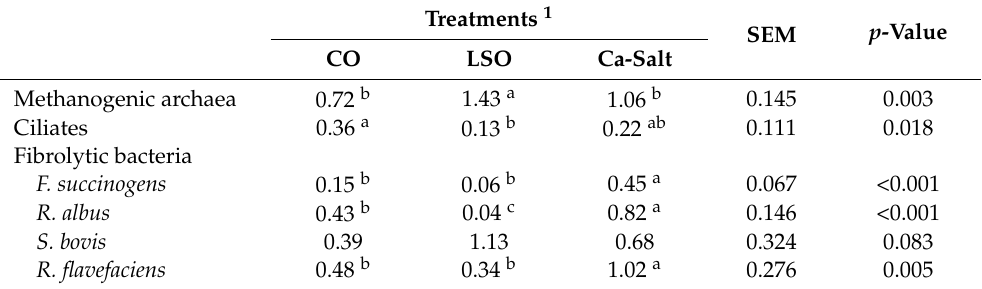
Table 5. Effects of oil sources supplementation containing essential fatty acid on rumen microbes after 24 h of incubation (fold change unit). Treatments 1 SEM p -Value CO